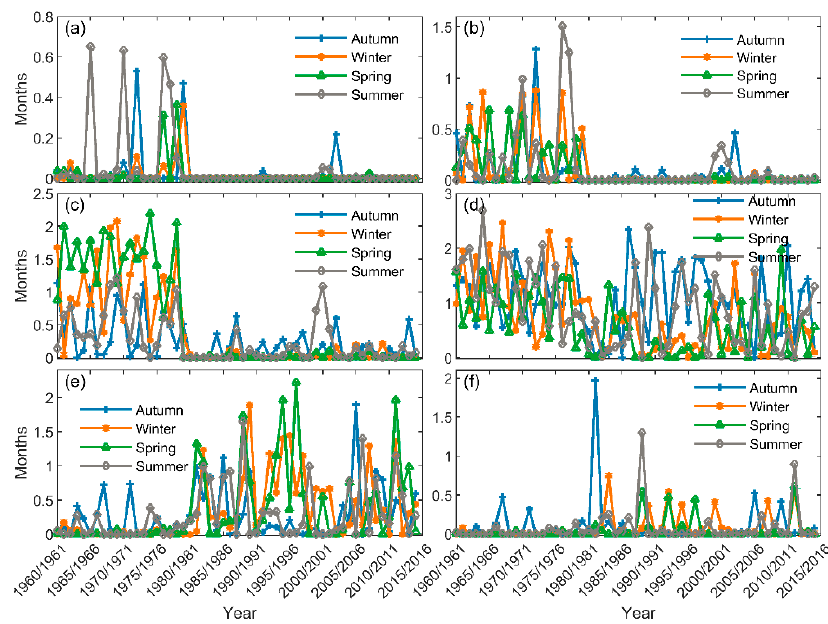
Figure 9. Changes in frequency of drought and wetness events of different magnitudes in SRYRB during 1960–2015 at the season scale. ( a ) Extreme drought, ( b ) severe drought, ( c ) moderate drought, ( d ) mild drought, ( e ) moderate wetness and ( f ) severe and extreme wetness. Table 5. Change rates (mon/decade) and associated significances for drought and wetness events of different magnitudes in SRYRB during 1960–2015 on the season scale. Asterisks denote the significance of 0.05 level.